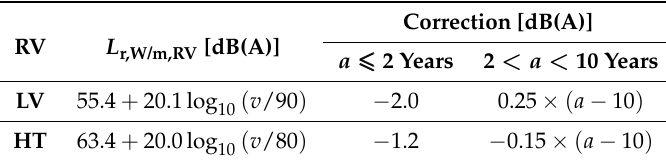
Table 2. Rolling noise components of the emission powers per metre of lane for LV and HT at speed v (between 20 and 130 km/h) with their respective corrections associated with the age a (in years) of the road segment (the formulas correspond with the surfacing category R2 in the methodological guide of the Sétra [62] (Tables 2.4–2.6)).